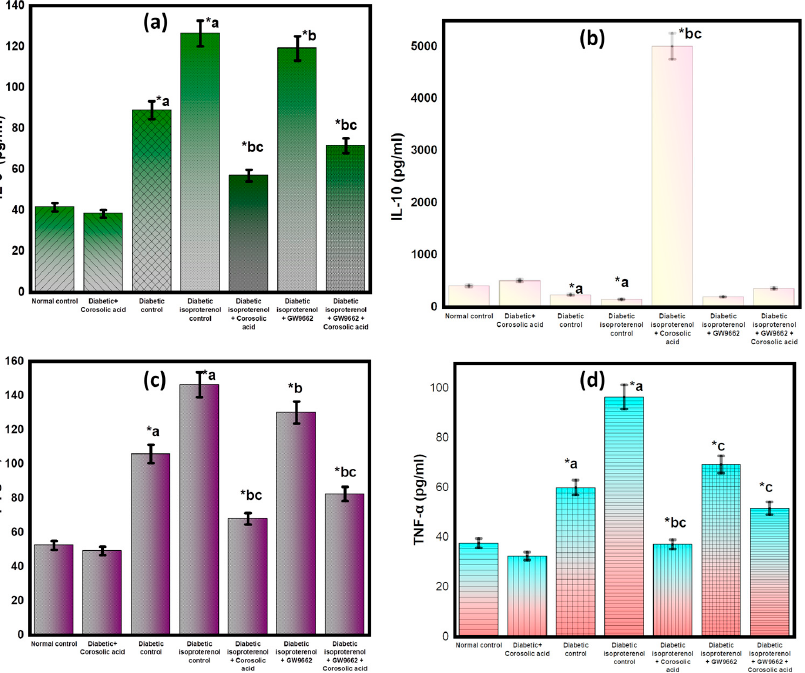
Figure 7. The effects of corosolic acid on proinflammatory cytokines ( a ) IL-6; ( b ) IL-10; ( c ) IL-1 β ; ( d ) TNF- α . The data are expressed as mean ± SEM. * p ≤ 0.05 is considered significant. a normal control vs. diabetic control and diabetic isoproterenol control; b diabetic control vs. corosolic acid and GW9662 treatments; and c diabetic isoproterenol control vs corosolic acid and GW9662 treatments.